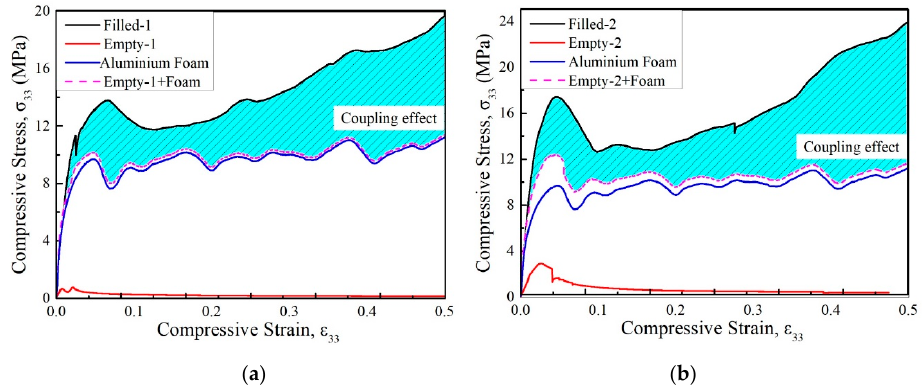
Figure 6. Coupling effect between Y-shaped core members and aluminum foam. The dashed line shows the sum of the stress–strain curve of empty and aluminum foam, which were tested separately. Core member thickness: ( a ) t = 0.41 mm; ( b ) t = 0.82 mm.